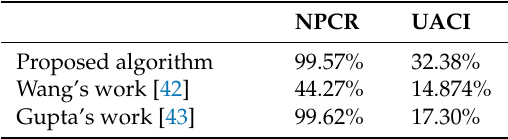
Table 4. The value of NPCR and UACI for